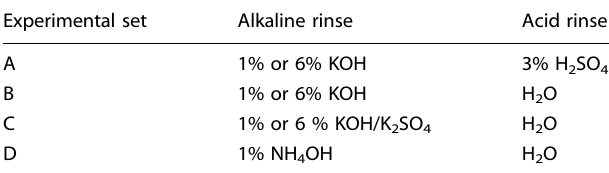
Table 1. Regenerant solution formulation per experimental set. Experimental set